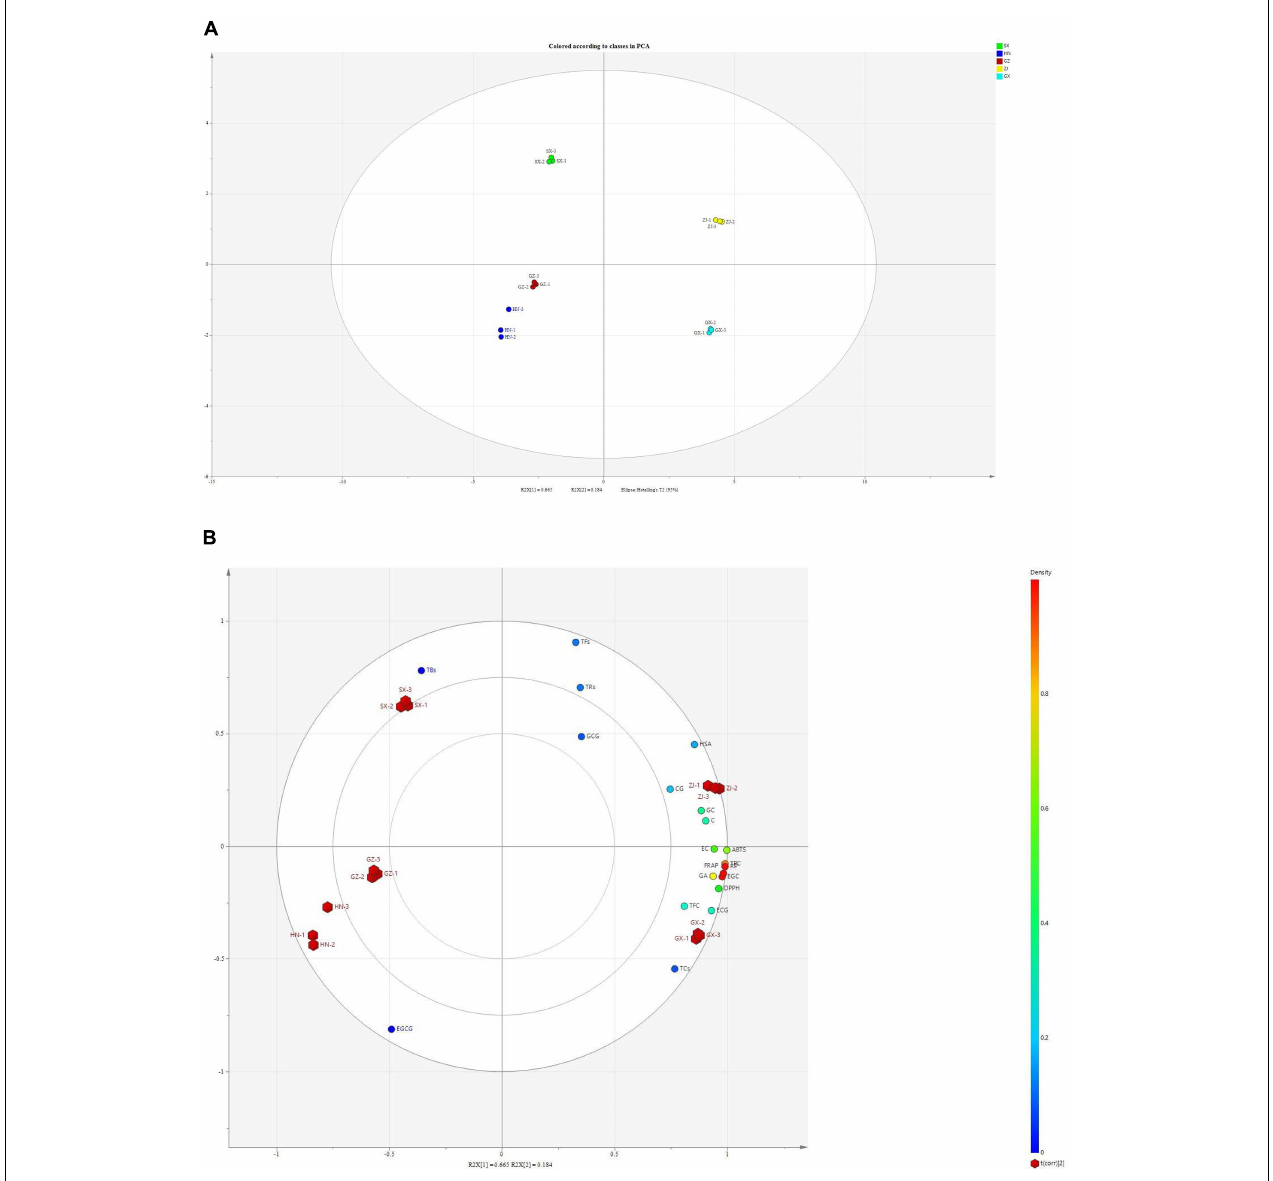
FIGURE 8 | Principal component analysis score (A) and loading plot (B) assessing the metabolites and antioxidant activity of five Fu brick teas in different regions.